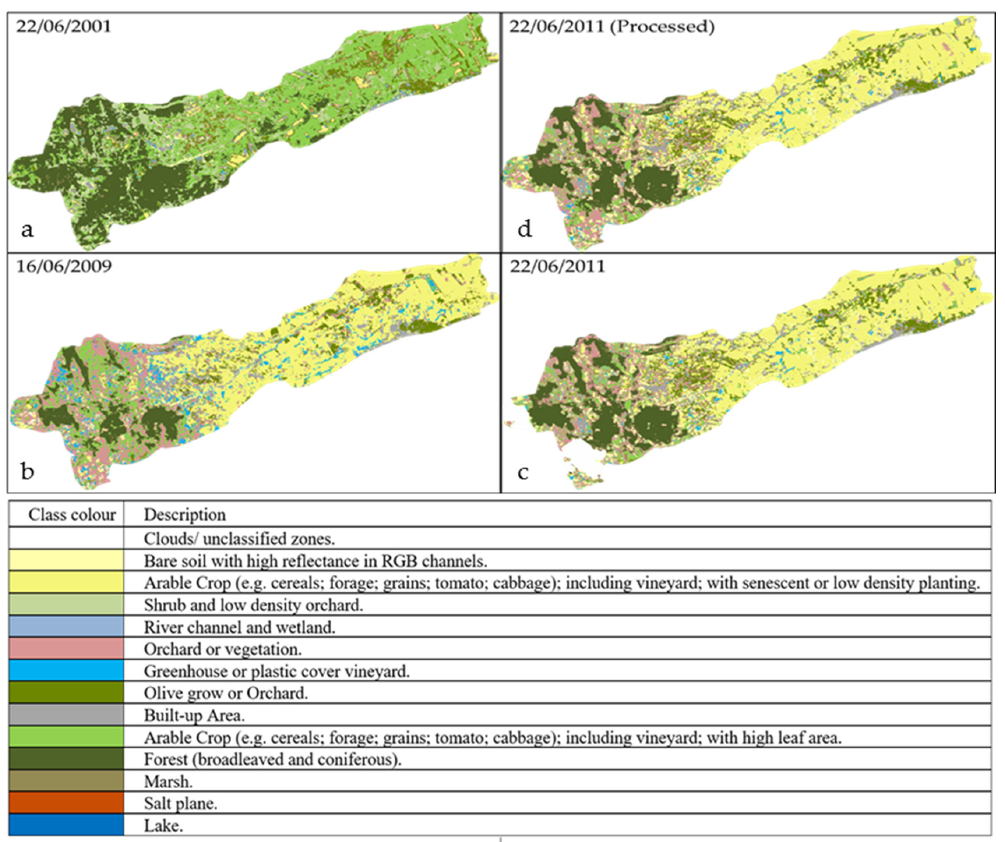
Figure 3. 2001 Landsat image classification ( a ). 2009 Landsat image classification ( b ). 2011 Landsat image classification ( c ). 2011 processed Landsat image classification.2.3.2. Land Vegetation Cover ( d ).